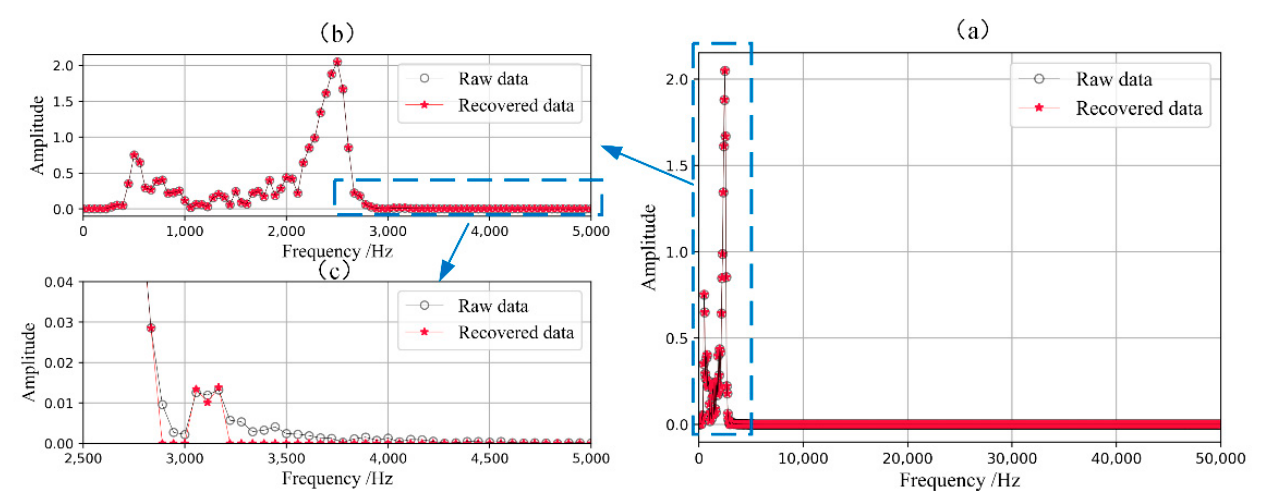
Figure 4. Spectra of raw and recovered data: ( a ) all spectrum data; ( b ) detail of non-zero values; ( c ) detail of zero values.